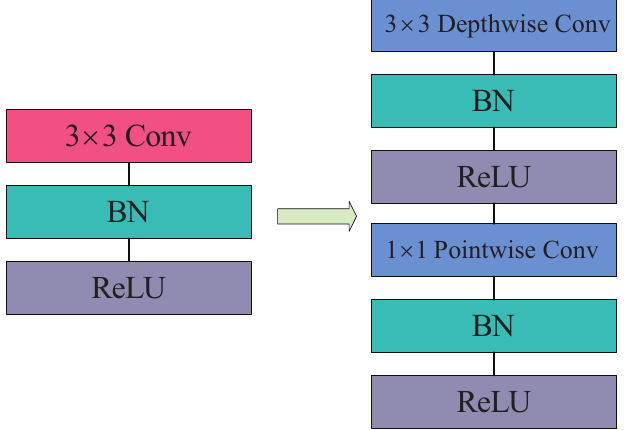
Figure 5. The basic structure of the deep separable convolutional